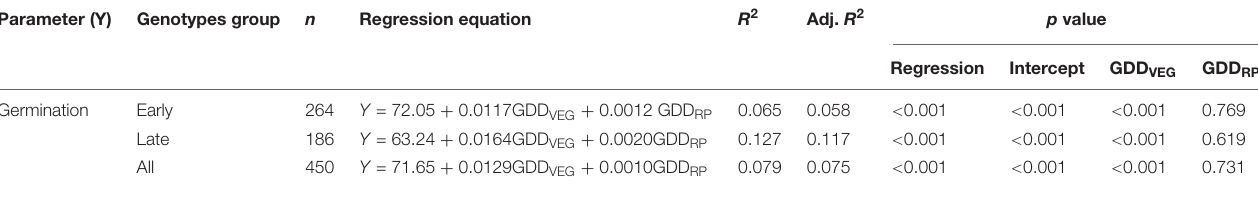
TABLE 4 | Regression equations and association between germination with growing degree days (GDD) in field